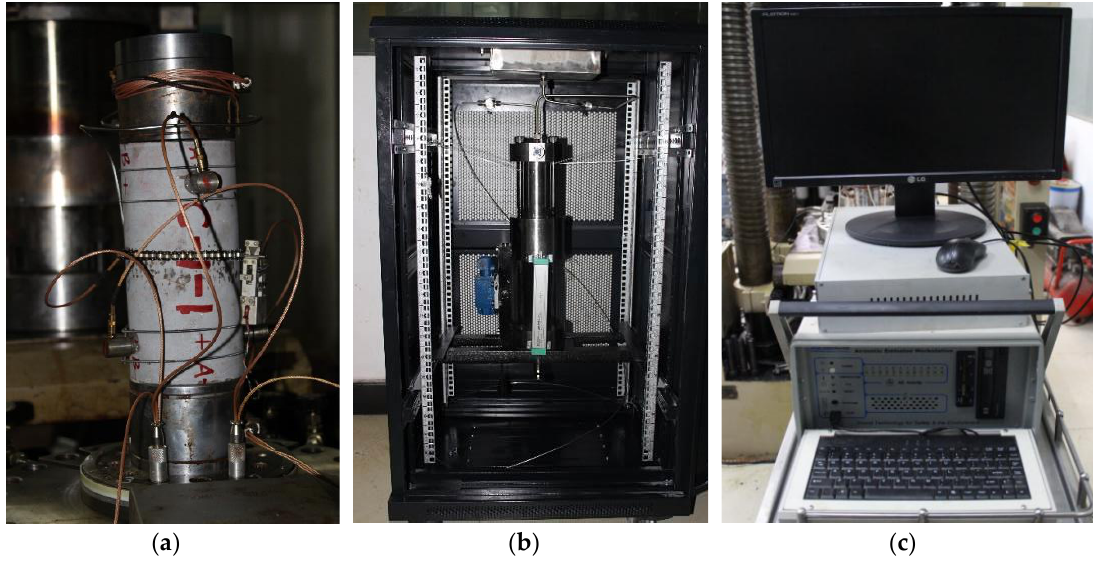
Figure 2. Hydraulic fracturing test system: ( a ) Rock mechanic testing system; ( b ) fracturing fluid pump injection system; ( c ) acoustic emission (AE) system.